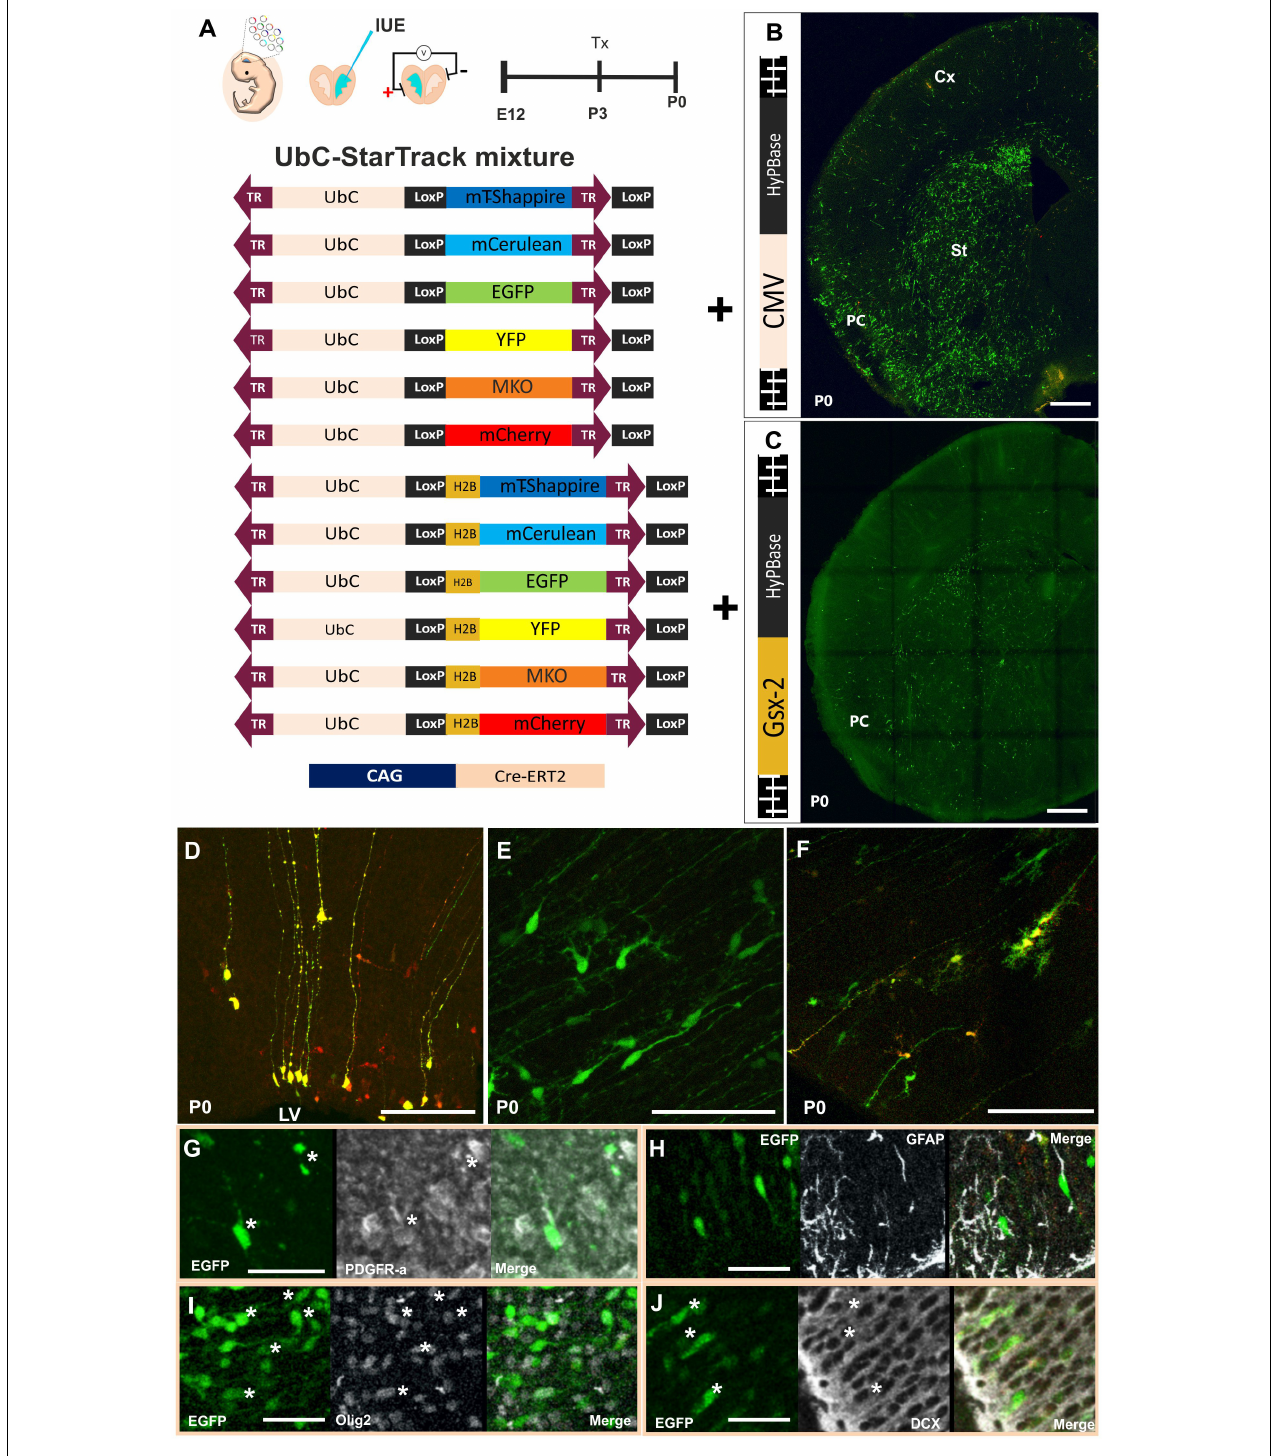
FIGURE 1 | Specific targeting of subpallial progenitor cells using new StarTrack approaches. (A) Scheme of ventral IUE: injection of UbC-StarTrack mixture using (B) CMV-transposase, showing an image of the labeled cells at P0, or (C) Gsx-2 transposase and their derived-labeled cell progeny at P0. (D–F) Cell progeny derived from E12-progenitors located close to the ventricular zone with similar morphologies to radial glial cells (D) , immature neurons and glial progenitor cells (E,F) at P0 using either UbC-StarTrack or UbC-(Gsx-2-PB)-StarTrack. These cells co-expressed different markers such as PDGFR- α (G) , GFAP (H) , Olig2 (I) , and DCX (J) showed with asterisks (*). IUE, in utero electroporation; LV, lateral ventricle; PC, piriform cortex; St, striatum; Cx, cerebral cortex; Tx, tamoxifen. Scale bar: 100 µ m (B,C) ; 50 µ m (D–J) .